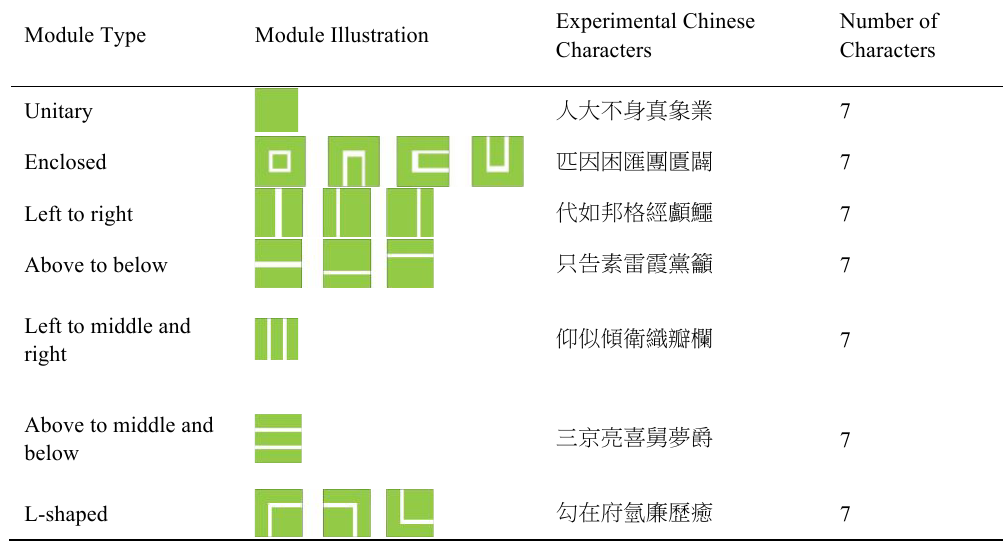
Module Type Module